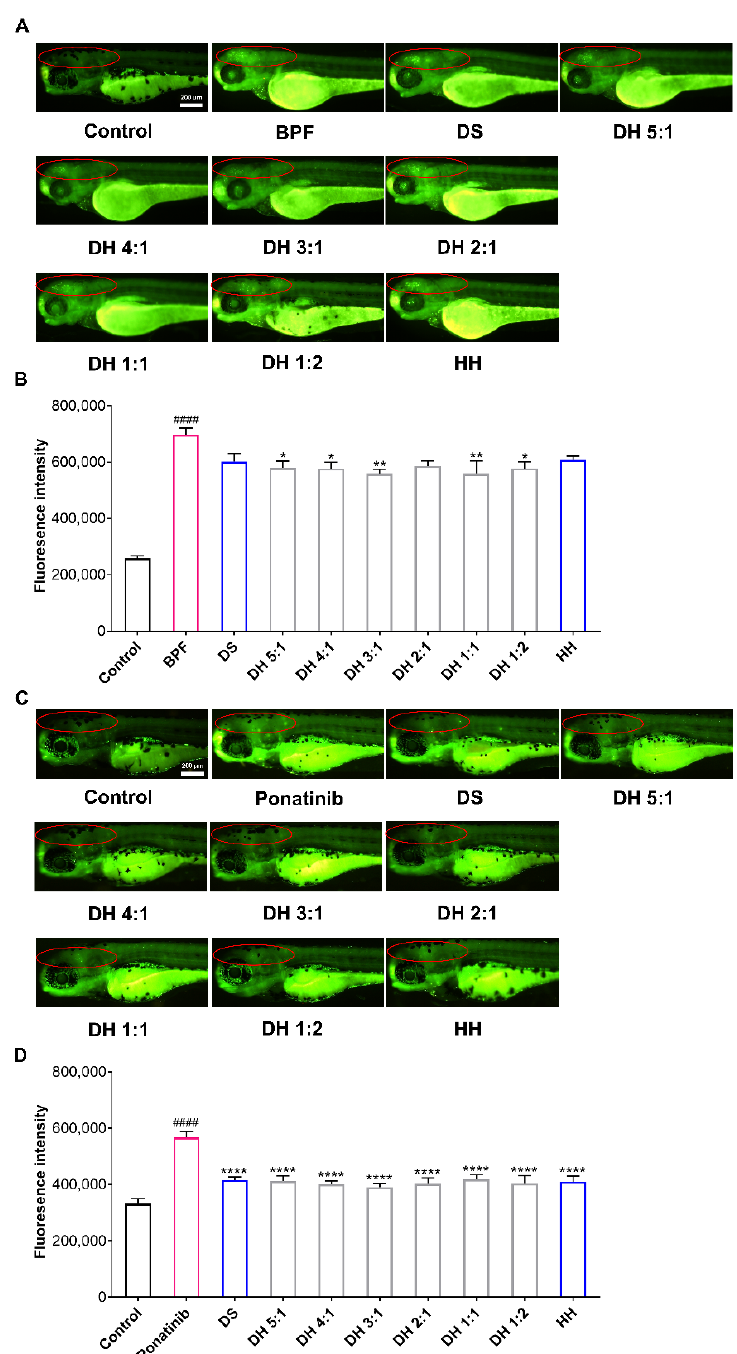
Figure 2. The DH herbal pair improved the brain injuryof zebrafish. ( A ) The zebrafish neurological injury model induced by bisphenol F (BPF) (10 μ g/mL) and the neuroprotective efficacy of DS, HH, and the DH herbal pair. ( B ) After treatment with BPF or designated drugs, the fluorescence intensity in the brains (in the red circle) of the zebrafish was quantified with the Image J software. ( C ) The zebrafish ischemic stroke model induced by ponatinib (1 µ g/mL) and the neuroprotective efficacy of DS, HH, and the DH herbal pair. ( D ) After treatment with ponatinib or designated drugs, the fluorescence intensity in the brains (in the red circle) of the zebrafish was quantified with the Image J software. The data are presented as mean ± SEM (n = 10). DS: Danshen; HH: Honghua; DH: Danshen-Honghua. * p < 0.05, ** p < 0.01, **** p < 0.0001 vs. model group; #### p < 0.0001 vs. control